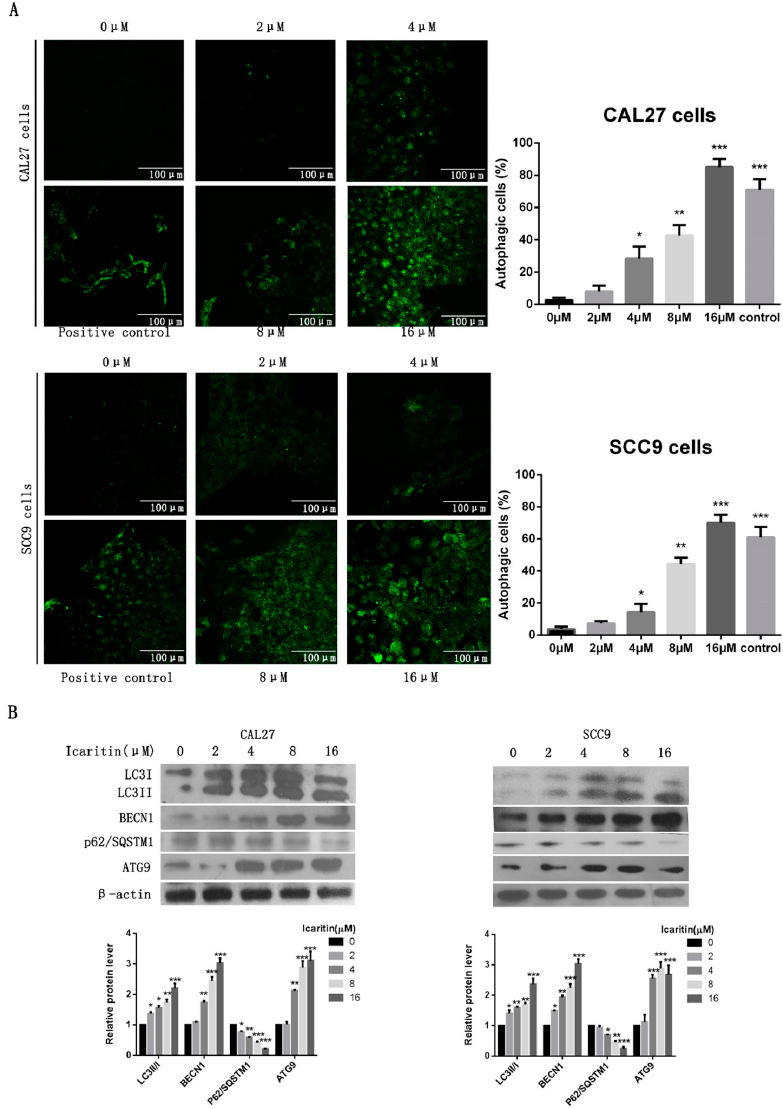
Figure 4. Icaritin triggered OSCC cell autophagy. ( A ) Representative images of MDC staining of CAL27 and SCC9 cells after icaritin treatment at the indicated concentration for 48 h. Punctated fluorescence in the cytoplasm indicated the formation of autophagic vacuoles. Magnification: ×400 for MDC staining. * p < 0.05; ** p < 0.01; and *** p < 0.001 versus 0 μ M group; ( B ) CAL27 and SCC9cells were treated with icaritin at different concentration for 48 h, and then LC3I/II, BECN1, p62/SQSTM1, and ATG9 were detected by western blot analysis. β -actin was used as a loading control. Relative density data of each protein was quantified by β -actin using Image J, and the data represented the mean of three independent experiments. * p < 0.05; ** p < 0.01; and *** p < 0.001 versus 0 μ M group.